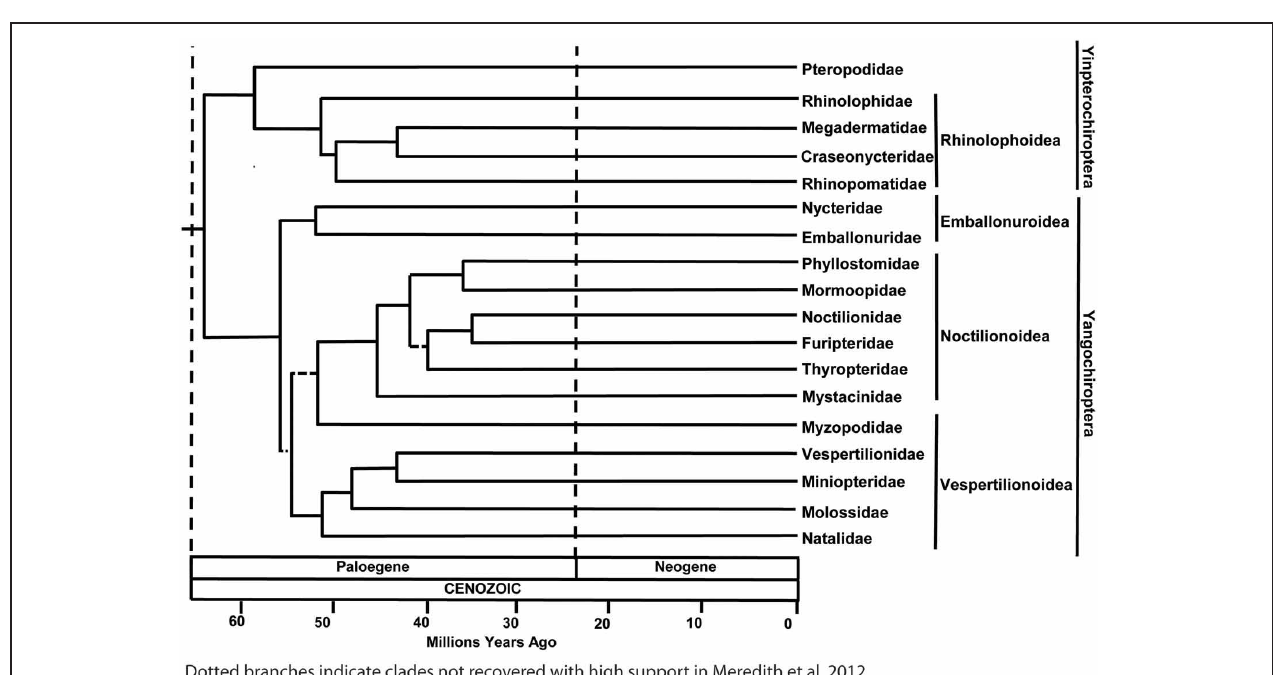
FIGURE 1 | Most recent phylogenetic arrangement of bat families based on dating and consensus analysis of amino acid and DNA analyses. Dotted lines represent branches not recovered with high support. See Meredith et al. (2011) for details. A newly suggested family,